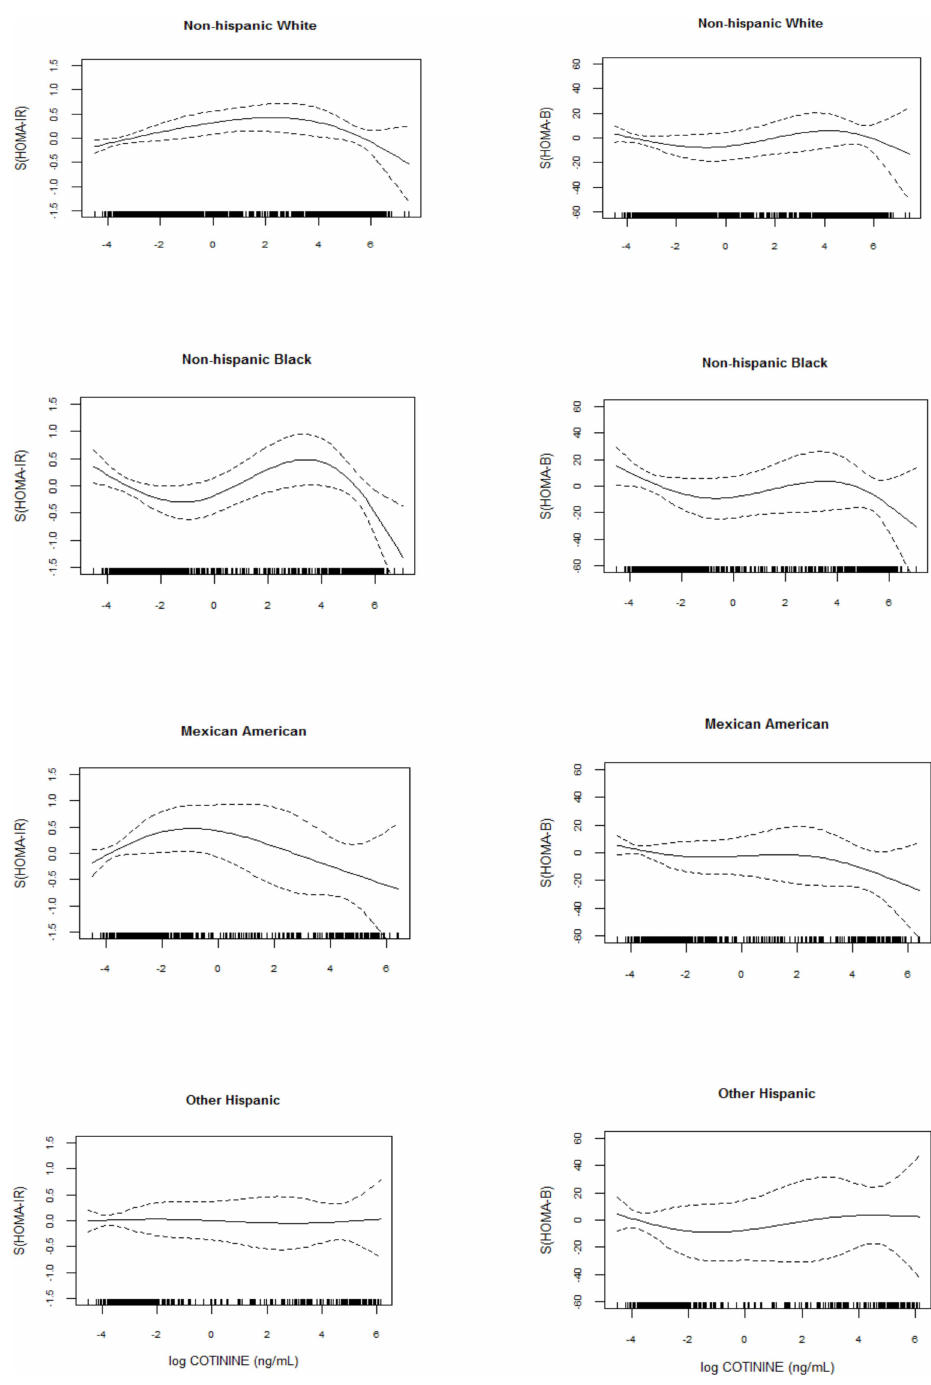
Fig 2. Smoothing plots of HOMA-IR and HOMA-B against cotinine by